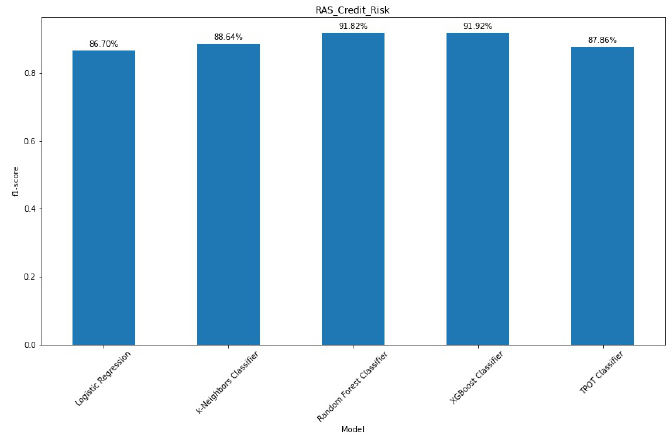
Figure 4. F1-scores of each model, using cross-validation approach.